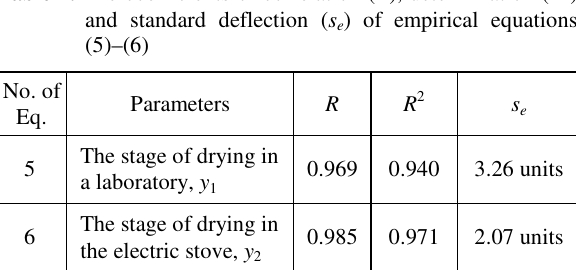
Table 7. The coefficients of correlation ( R ), determination ( R 2 ) and standard deflection ( s e ) of empirical equations